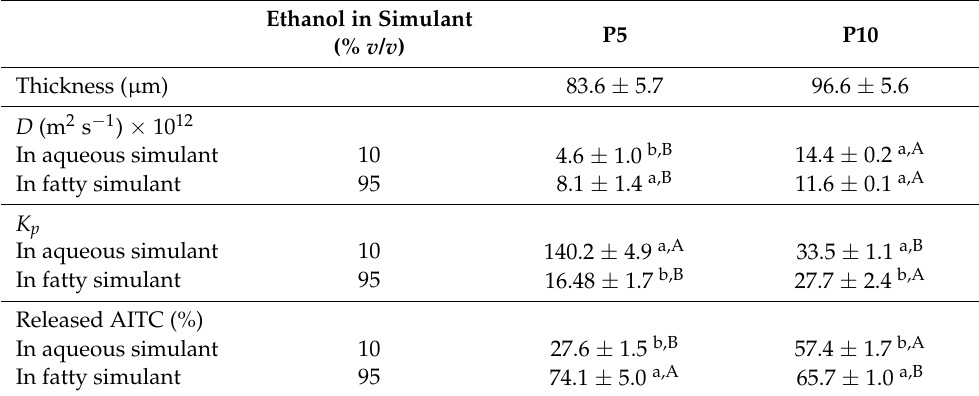
Table 2. Kinetic parameters for the release of allyl isothiocyanate from active poly(lactic acid) films to different food simulants, obtained from Fickian model